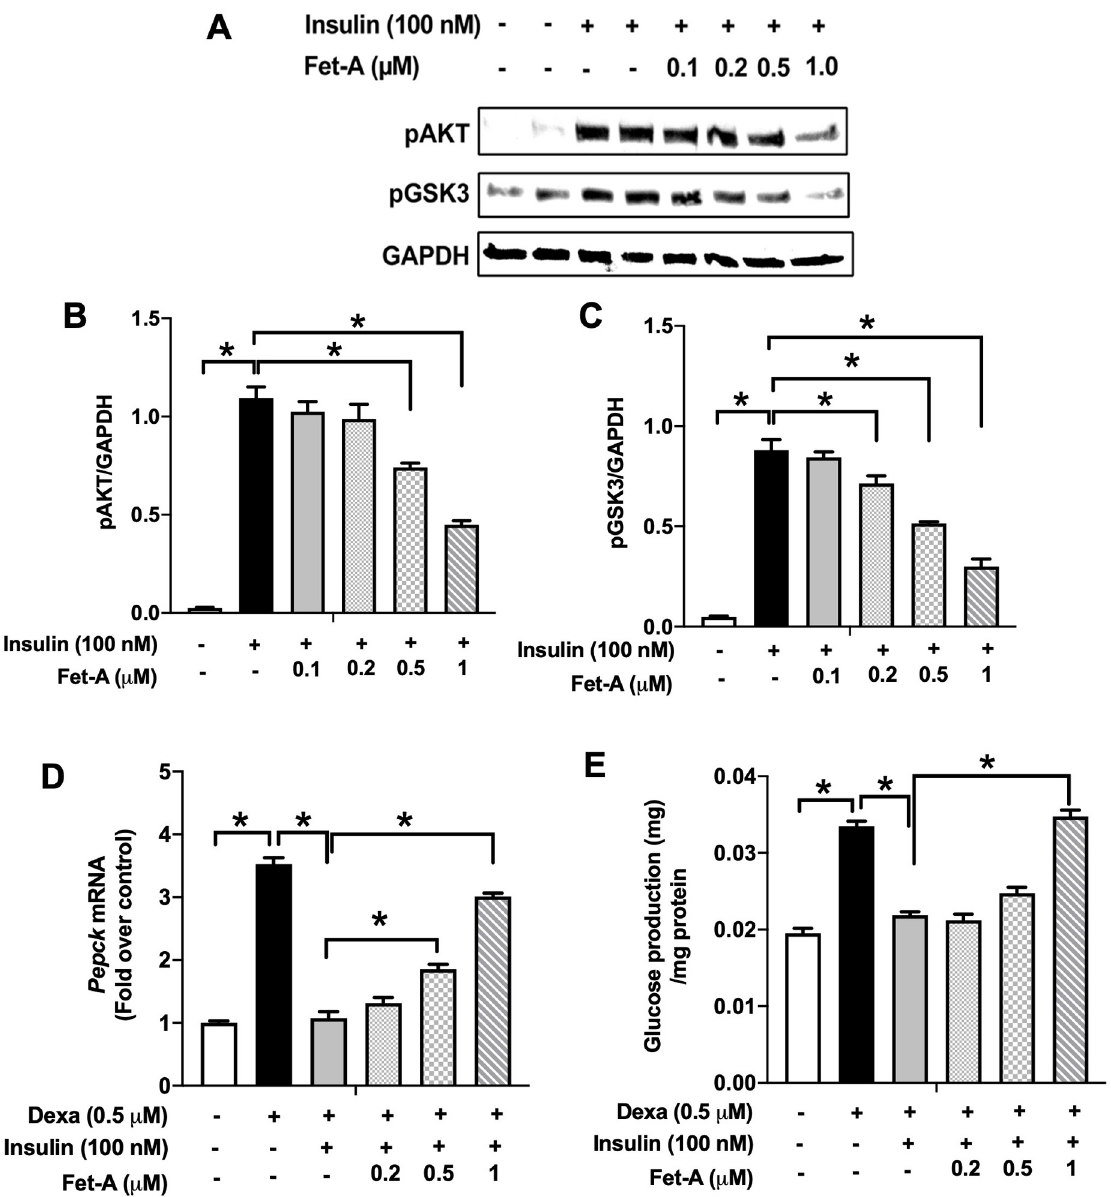
Fig 1. Effect of fetuin-A (Fet-A) on insulin signaling and insulin mediated suppression of gluconeogenesis and glucose production in HepG2. [A] HepG2 cells were pre-treated with recombinant Fet-A in the presence or absence of insulin, and cell lysates were subjected to immunoblotting for AKT and GSK3 phosphorylation status (n = 3). [B] Quantified data of the ratio of cellular pAKT/GAPDH immunoblots (n = 3) and C] ratio of cellular pGSK/GAPDH immunoblots (n = 3) are shown. [D] HepG2 cells were serum-starved for 6 h, followed by treatment with dexamethasone (Dexa), insulin, or insulin and Fet-A for 12 h. Real-time gene expression of Pepck were analyzed (n = 4). [E] To analyze glucose production, HepG2 cells (n = 4) were treated with 0.5 μ M dexamethasone and 0.1 mM 8-CTP-cAMP (Dex/ cAMP), various concentrations of Fet-A or 100 nM insulin (Ins) in glucose free DMEM medium (pH 7.4 supplied with 20 mM sodium lactate and 2 mM sodium pyruvate) for 5 h. Glucose production was assayed by measuring glucose concentration in the medium as described previously [33]. Data are shown as Means ± SEM. P values were determined by one-way ANOVA followed by Tukey’s multiple comparison tests (A-C). Data are representative of at least three independent experiments performed in replicates. � Indicates p < 0.05.